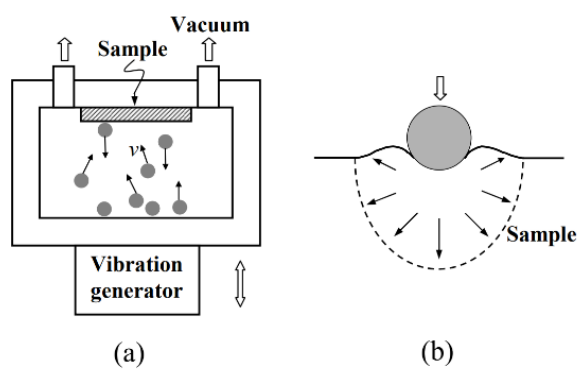
Figure 3. Schematic illustrations of the ( a ) SMAT setup and ( b ) localized plastic deformation in the surface layer of the treated sample, caused by the impact of balls reprinted with permission from Ref. [19]. Copyright 2022, ELSEVIER.